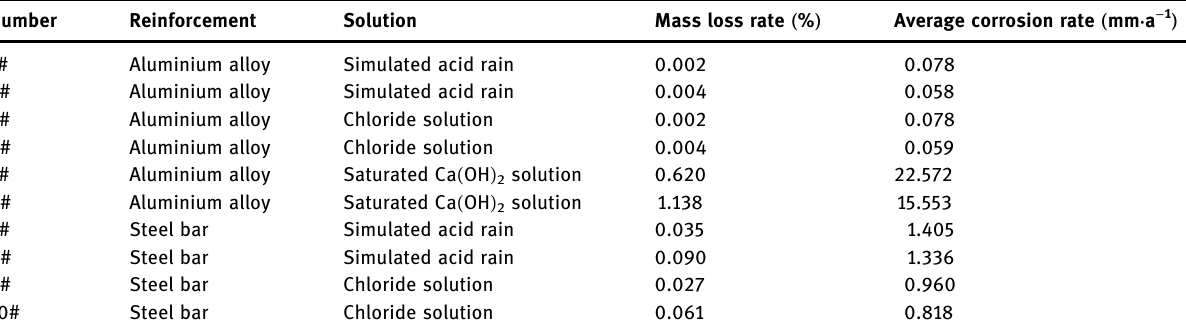
Table 5: Corrosion rate of